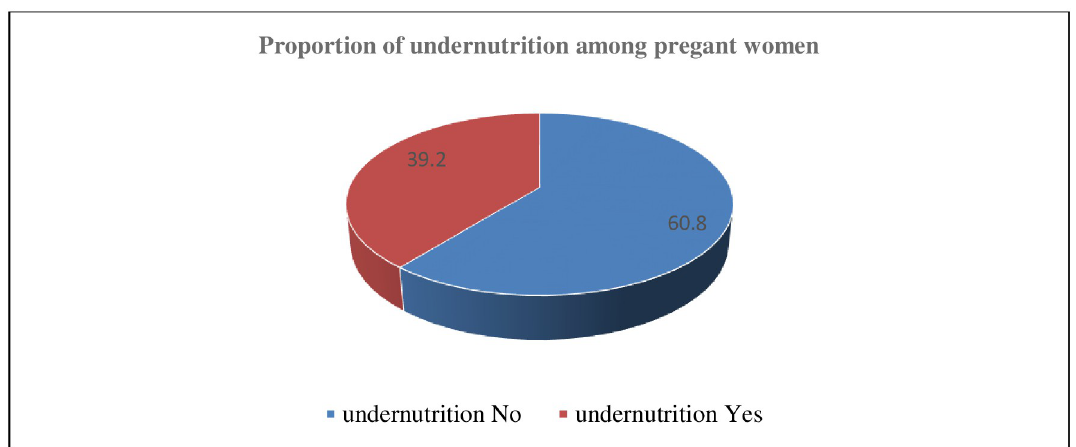
Fig 3. Nutritional status of participants attending ANC services at public hospitals of West Wollega